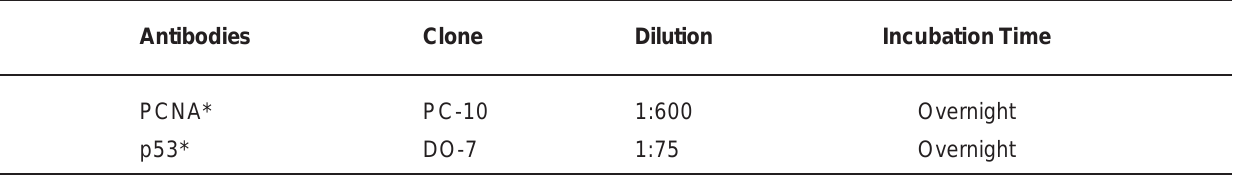
* Dako Corporation, Carpinteria